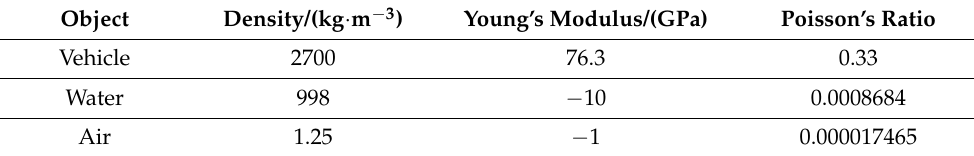
Figure 2. Calculation domain size.